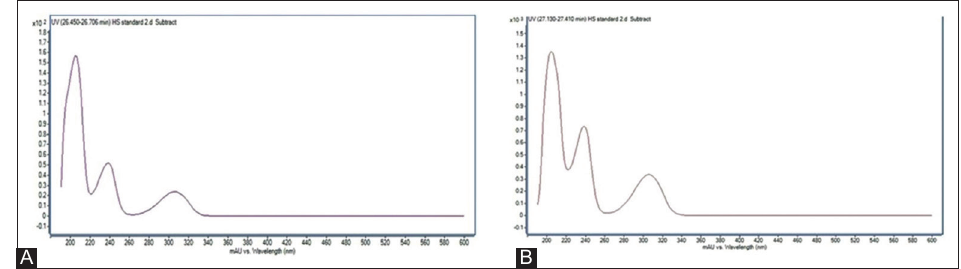
FIGURE 1. Determination of the maximum absorption of homosalate and the degree of purity of the homosalate standard. Ultraviolet spectrum of homosalate trans-isomer trans-homosalate standard (HS) (A) and cis-isomer cis-HS (B) was recorded at a wavelength range of 200–600 TABLE 2. Areas read from the HS chromatogram and calculated AM value, SD, and the CV Concentrations µ g/mL